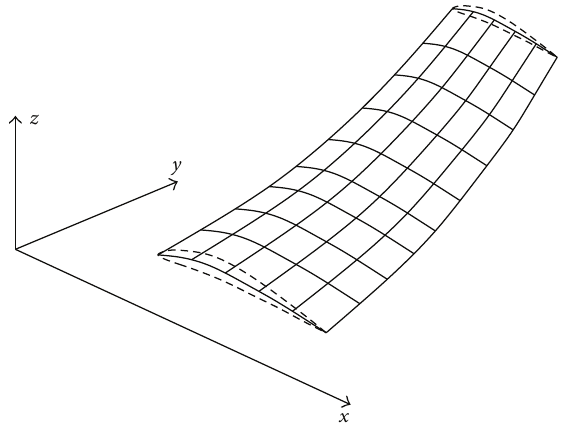
Figure 1: Nonplanar vortex lattice model for a thin lifting surface.